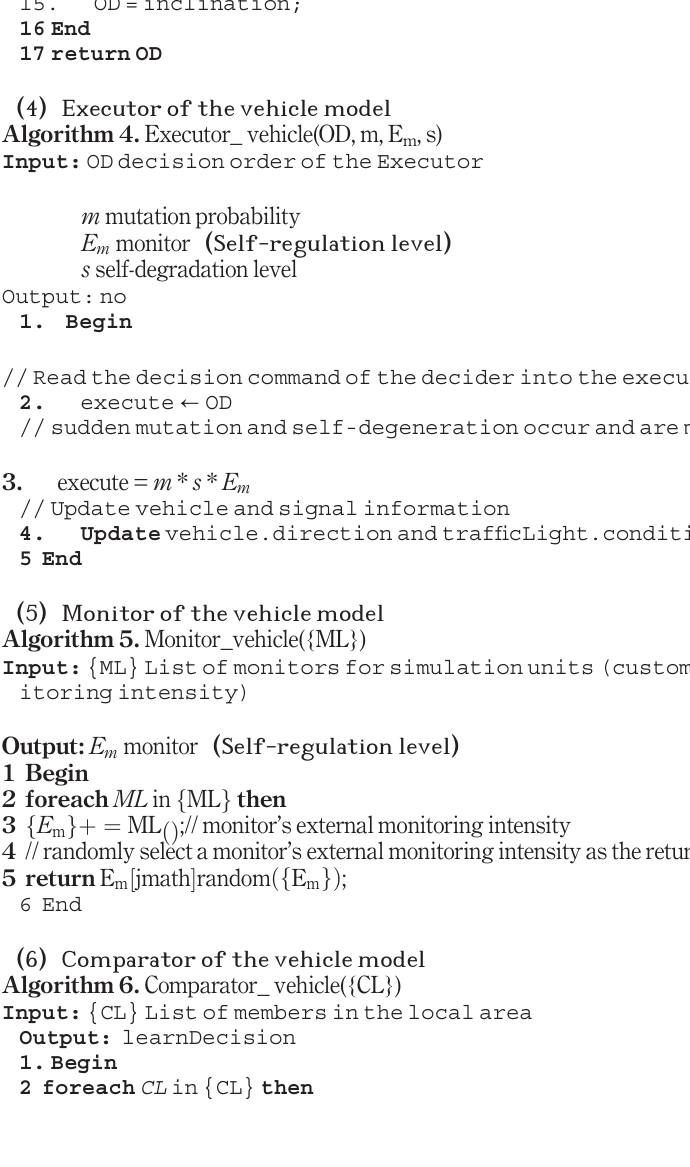
Algorithm 4. Executor_ vehicle(OD, m, E